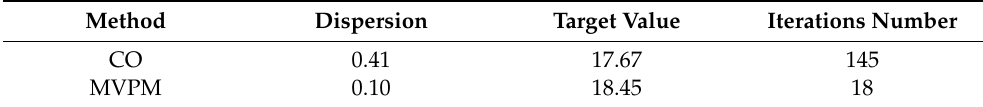
Table 3. Comparison of two